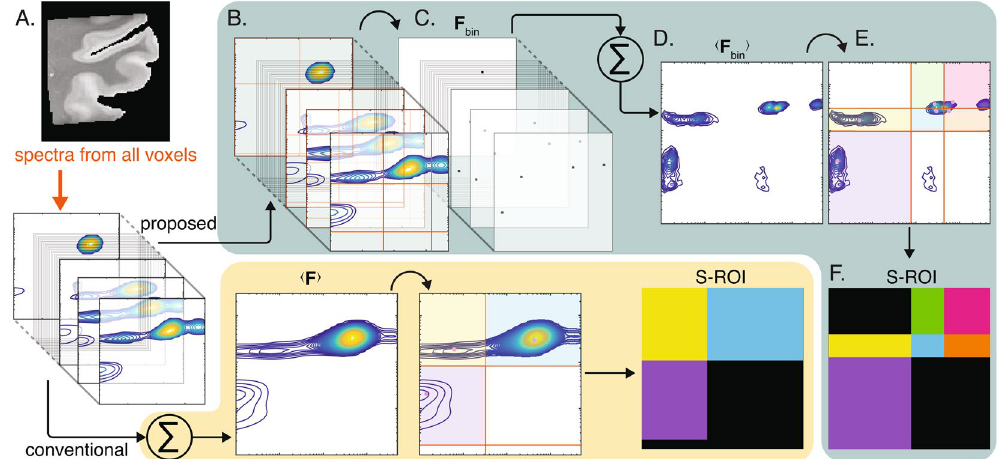
Figure 1. Overview of the proposed method, compared with the conventional approach. ( A ) Each voxel in a given image contains a 2D spectrum. Up to date, the only strategy to process the voxelwise spectra into images was to average them 24,28 , manually identify spectral components, and generate sROIs accordingly (bottom panel). To circumvent the obvious limitations of the standard approach we propose here to first ( B ) identify all possible spectral peaks in each voxel, and then ( C ) apply a threshold and obtain binary voxelwise spectra, F